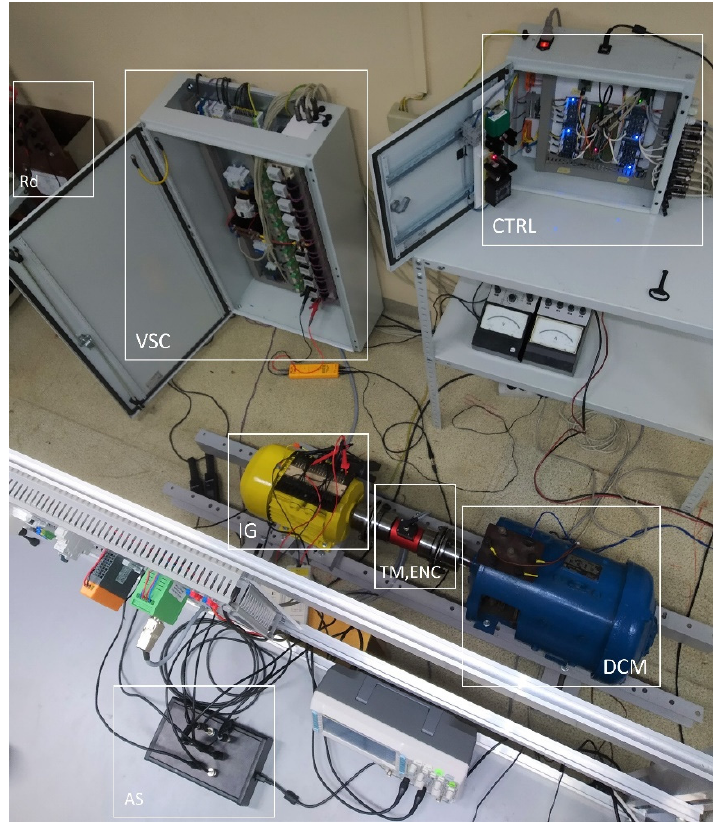
Figure 12. Laboratory test bench view: IG - induction generator, DCM — DC motor, TM — torque meter, ENC — encoder, VSC — IGBT voltage source converter, CTRL — control system, R d — load resistor, AS — acquisition and measurement equipment.